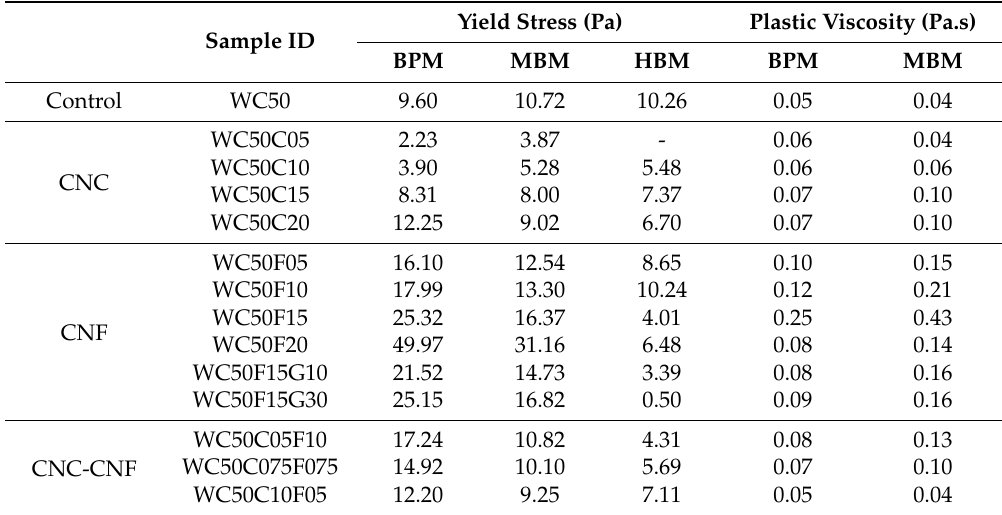
Table 4. Yield stress and plastic viscosity of OWC slurries calculated by different rheology models. Yield Stress (Pa) Plastic Viscosity (Pa.s) Sample ID BPM MBM HBM BPM MBM Control